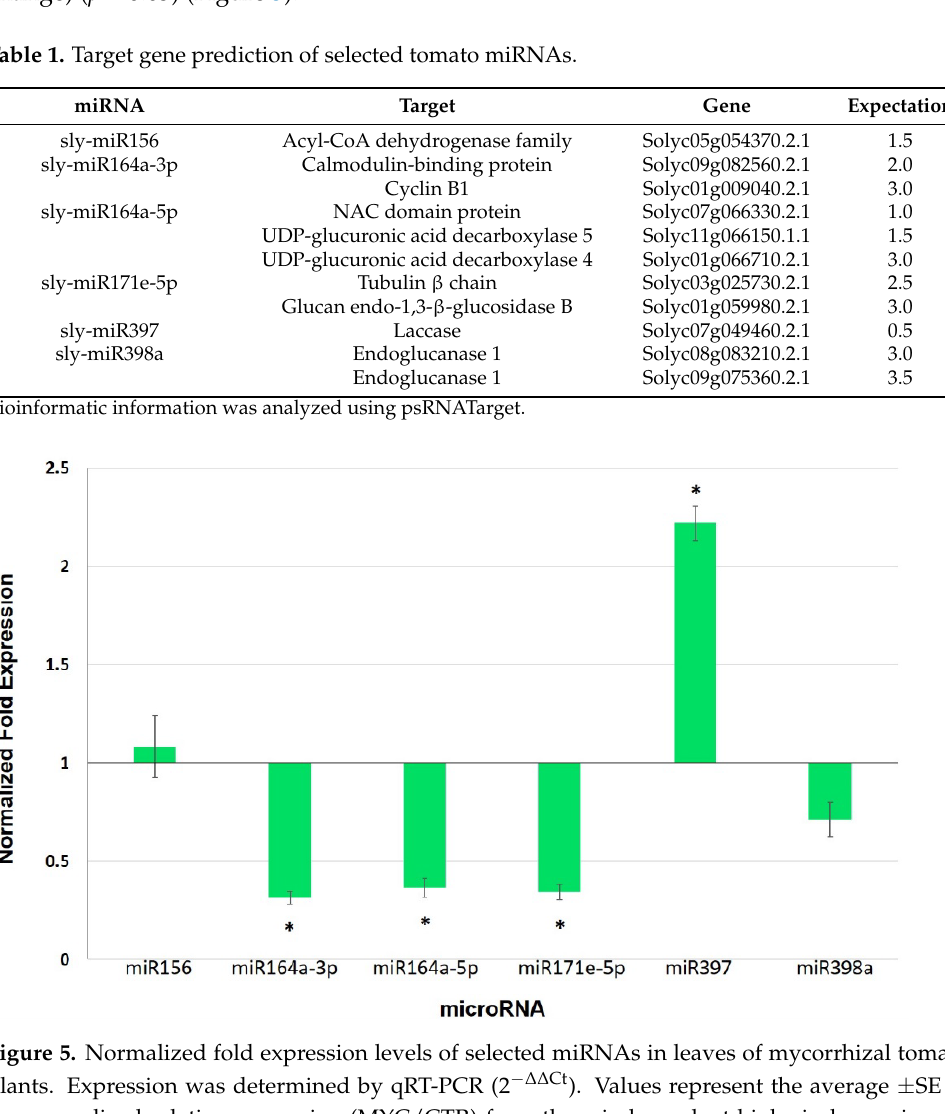
Figure 6. Normalized fold expression levels of miRNA target genes in leaves of mycorrhizal tomato plants. Expression was determined by qRT-PCR (2 −∆∆Ct ). Values represent the average ±SE of the normalized relative expression (MYC/CTR) from three independent biological experiments (n = 3 per experiment). Ubiquitin was used as a reference gene for data normalization. (*) represent signif- icantly different means between MYC/CTR according to the statistical analysis (Student’s t -test, p ≤ 0.05). Bars, ±SE. (CamBP: Calmodulin binding protein; CYC B1: Cyclin B1; NAC: NAC domain pro- tein; UDP-G-D5: UDP-glucoronic acid descarboxylase 5; UDP-G-D4: UDP-glucoronic acid descar- boxylase 4; Tub β chain: Tubulin beta chain; GE -1,3- β -gluc B: Glucan endo-1,3- β -glucosidase B; LAC: Laccase).